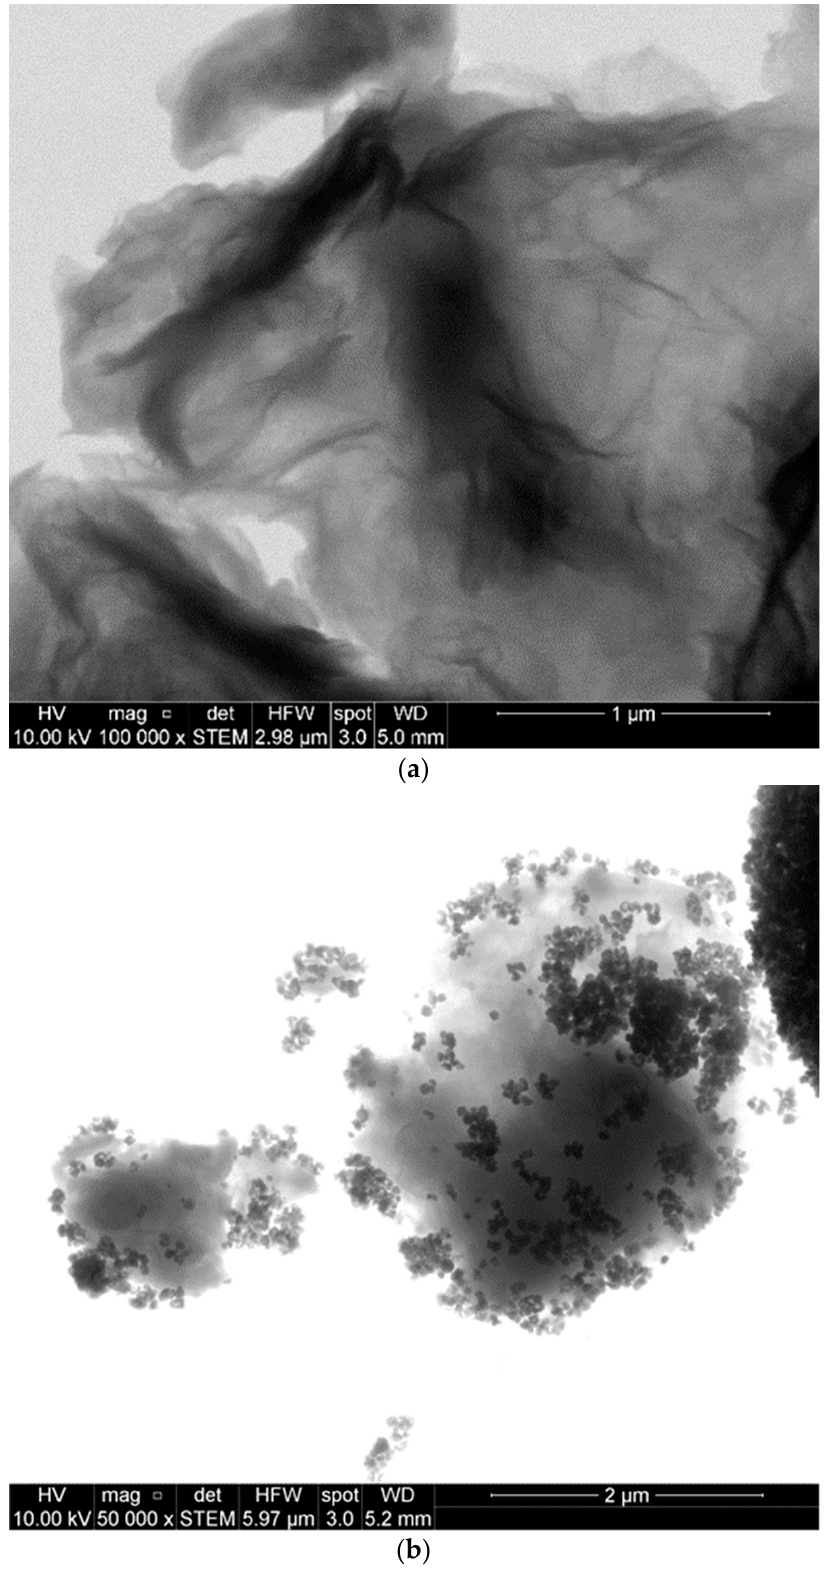
Figure 6. STEM images of rGO ( a ) and GO-g-PMMI/BTN ( b ), both at a magnification of 100,000×.